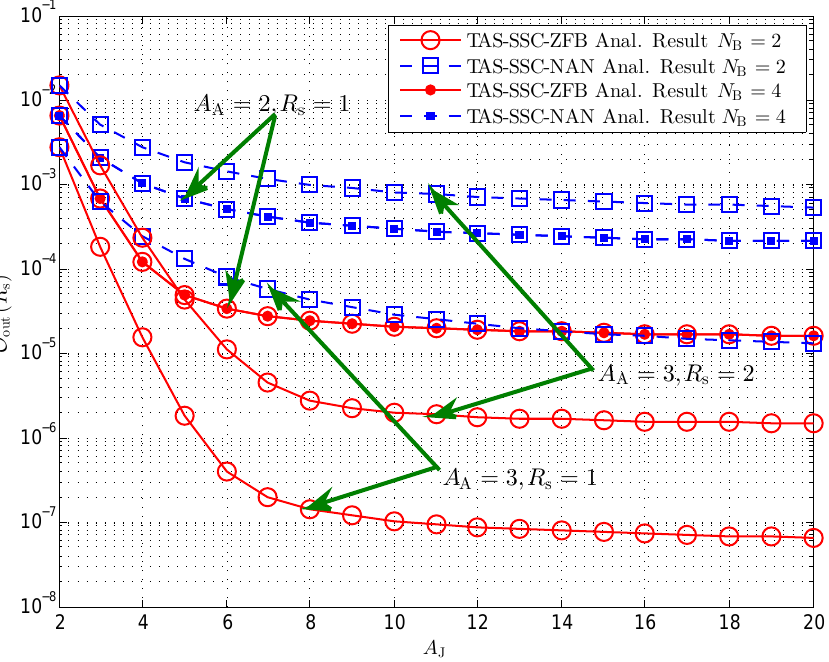
Figure 3. Secrecy outage probability versus different A J for γ T = 10 dB, M BE = 5, γ S = 20 dBW, and φ =